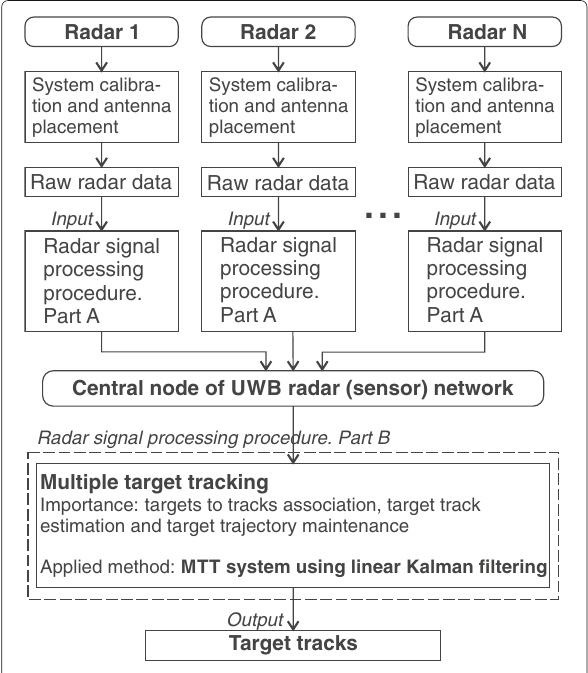
Fig. 8 Block diagram of radar signal processing procedure for UWB radar (sensor)